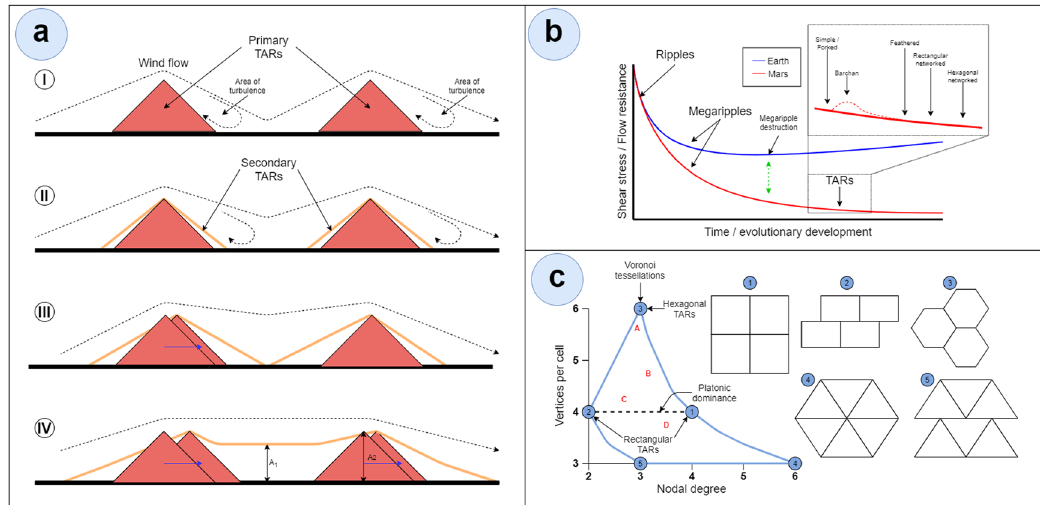
Fig. 5 Conceptual models of TAR development. a Pro fi le view of TARs transitioning from 3D fl ow to 2D fl ow. See text for a detailed description. b Conceptual model of TAR development on Mars (red line) compared with Earth (blue line). The dashed green arrow marks the point where megaripples on Earth are fl attened as they increase in height 33,58,59 . The inset illustrates morphological evolution. c All possible convex tiling combinations (surrounded in blue). Natural phenomena in red: (A) basalt fracturing, (B) permafrost, (C) mud cracks, and (D) surface fractures in granite. After Domokos et al.